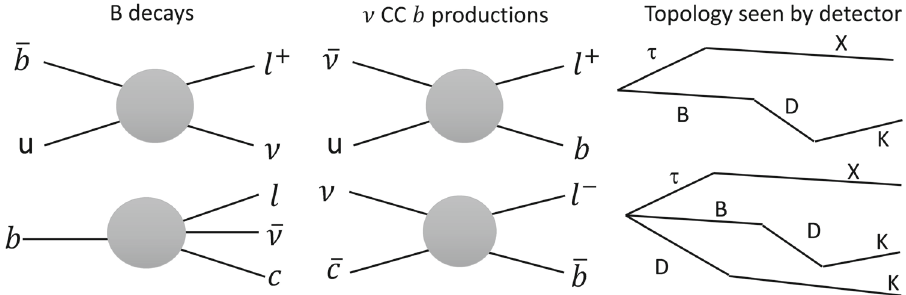
Fig. 20 Left : Diagrams of purely leptonic (upper) and semi-leptonic (lower) beauty decays. Center : The corresponding neutrino CC inter- actions with b quark production. In the bottom diagram, perturbative